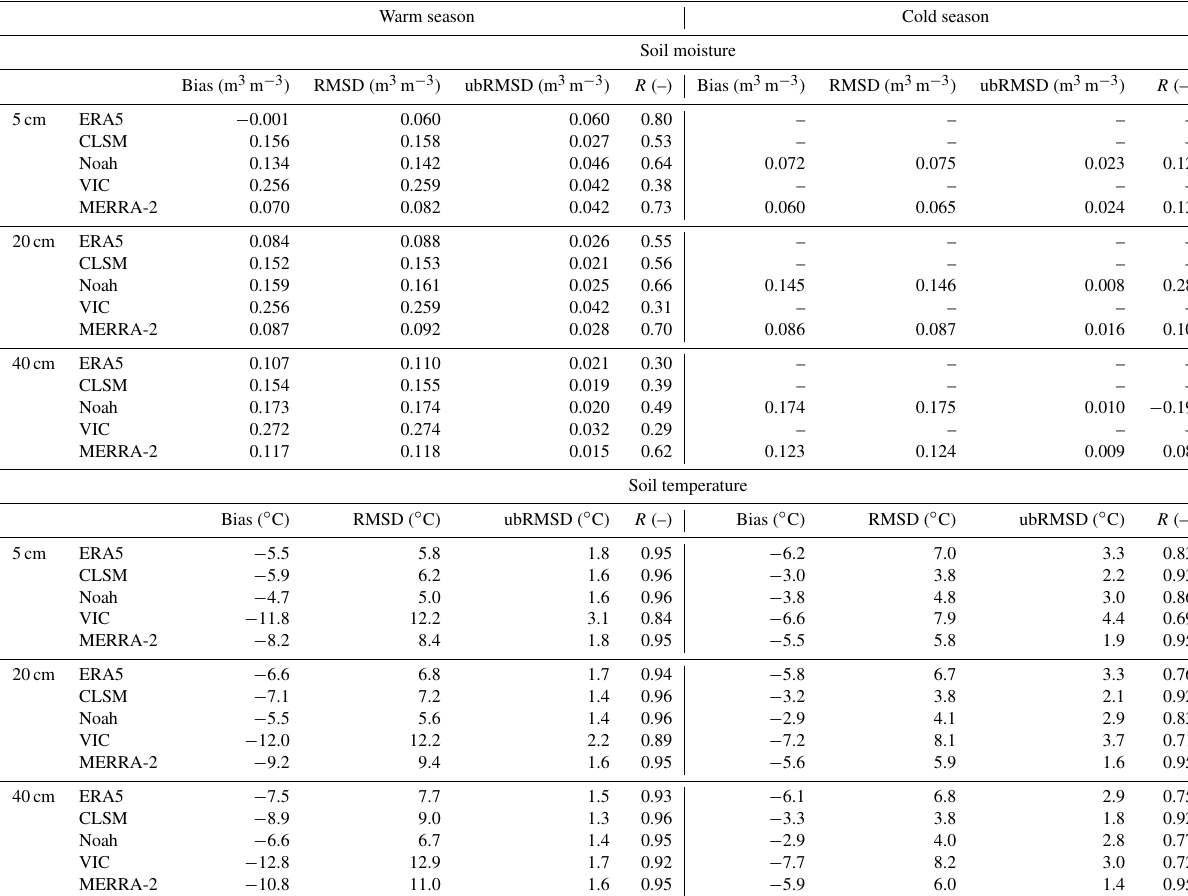
Table 6. Same as Table 5 but for the Shiquanhe